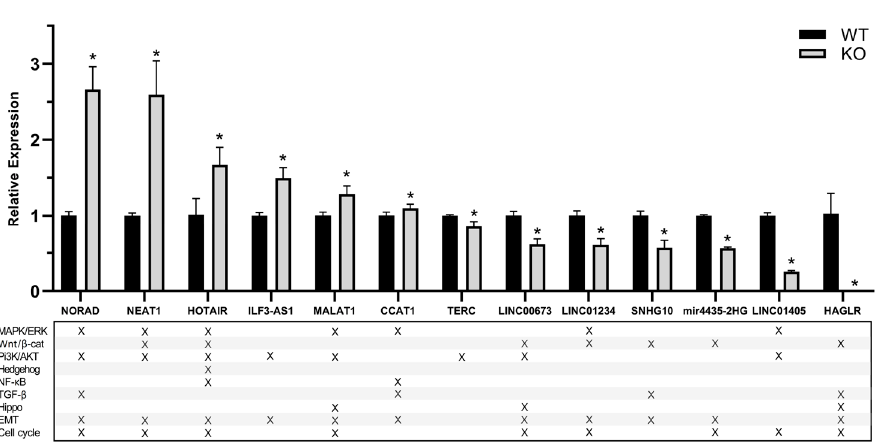
Figure 6. Changes in the expression of selected lncRNAs measured by RT-qPCR. The lower panel shows the signaling pathway and the cellular process they are known to be involved in. Results significant at p > 0.005 are marked with an